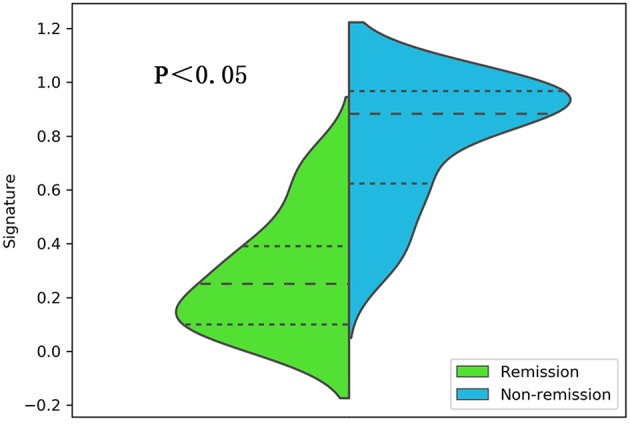
A violin plot comparing the distribution of the radiomics signatures between the different radiotherapeutic response (remission and non-remission) groups.